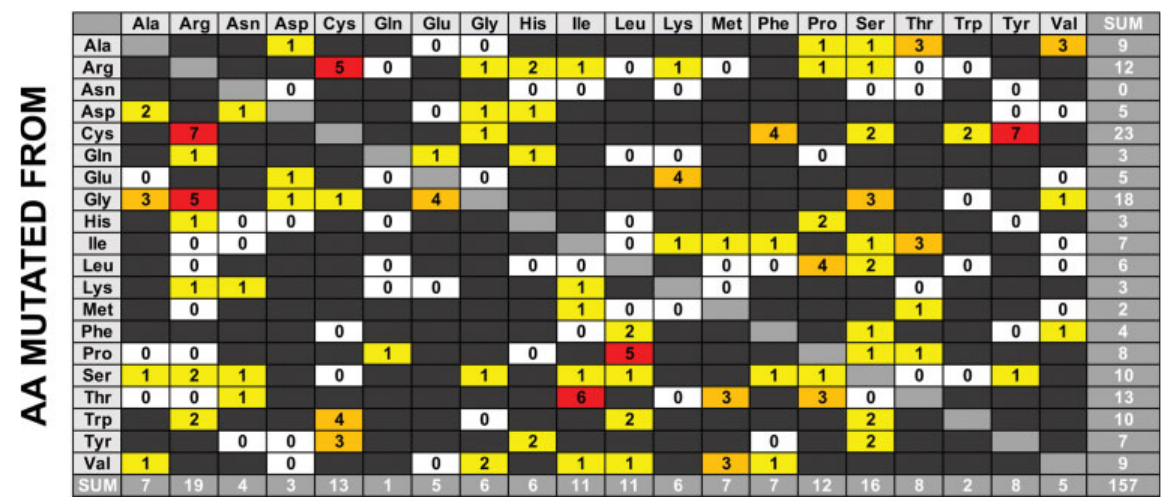
Fig.4 Substitution grid representing 157 missense variants (including eight polymorphisms) in the F11 gene. The grid illustrates the number of variants of each de fi ned amino acid change. All substitutions shown are the result of a single nucleotide change. Any substitutions that require more than a single nucleotide change are shown in dark gray boxes. Silent variants are excluded from the grid and shown in pale gray. The white boxes represent possible substitutions that do not occur in the F11 gene. The yellow boxes represent substitutions that occur once or twice, the orange boxes represent substitutions that occur three or four times and the red boxes represent substitutions that occur fi ve or more